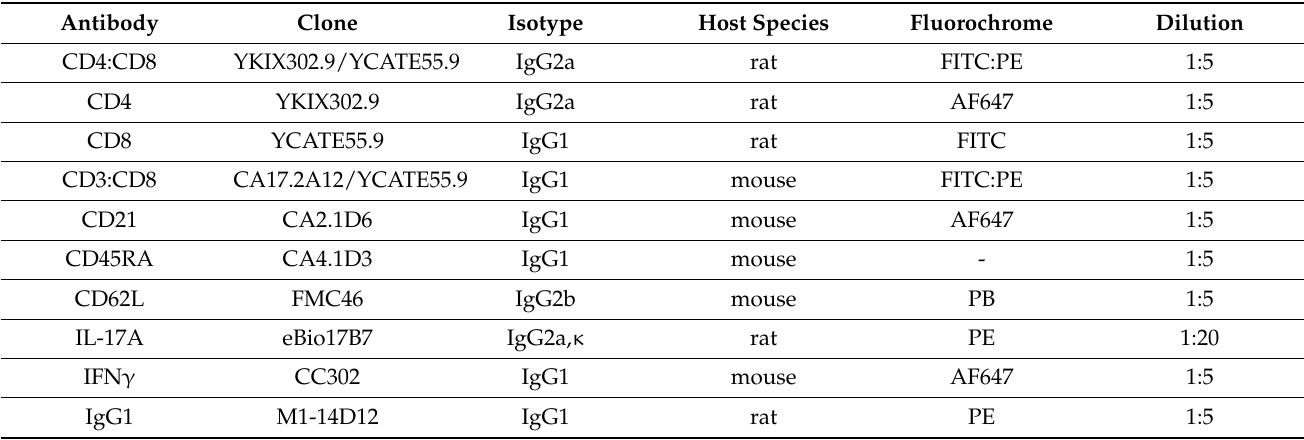
Table 1. Monoclonal antibodies used in the study for labeling peripheral blood mononuclear cells (PBMCs) for flow cytometry. Abbreviations: FITC—fluorescein isothiocyanate, PE—phycoerythrin, AF647—Alexa Fluor 647, PB—Pacific